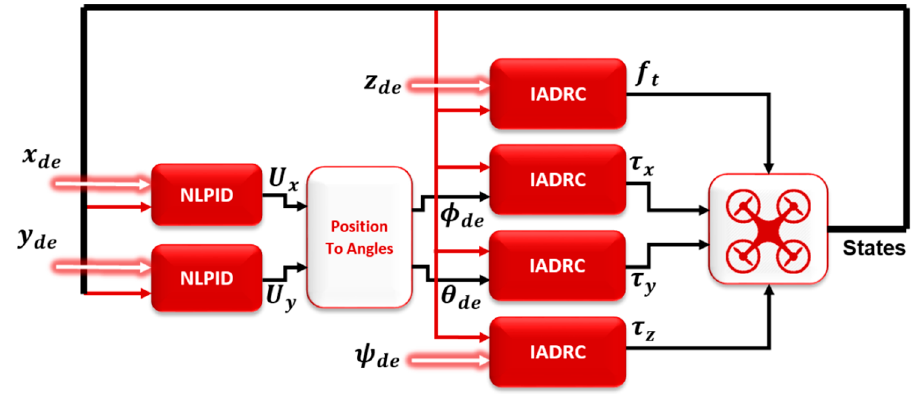
Figure 4. IADRC control for ILC and NLPID control for OLC of quadrotor system.